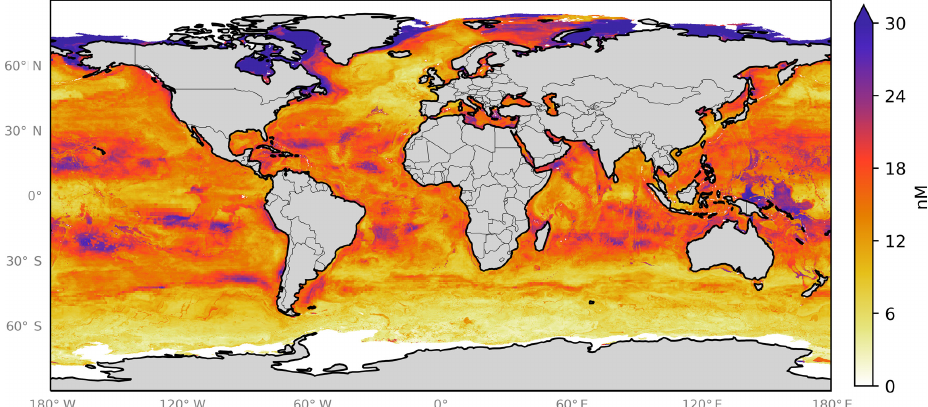
Figure A4. Annual average spatial uncertainty in predicted sea-surface iodide for the ensemble of 10 models. Spatial variation was calculated as the standard deviation in monthly average values for all models. Values are limited to 30nM for contrast, and the maximum value plotted is 52nM in the northern high latitudes. Only locations that are entirely water are included in spatial the average. Earth raster and vector map data used are freely available from Natural Earth (http://www.naturalearthdata.com/, last access: 23 July 2019).